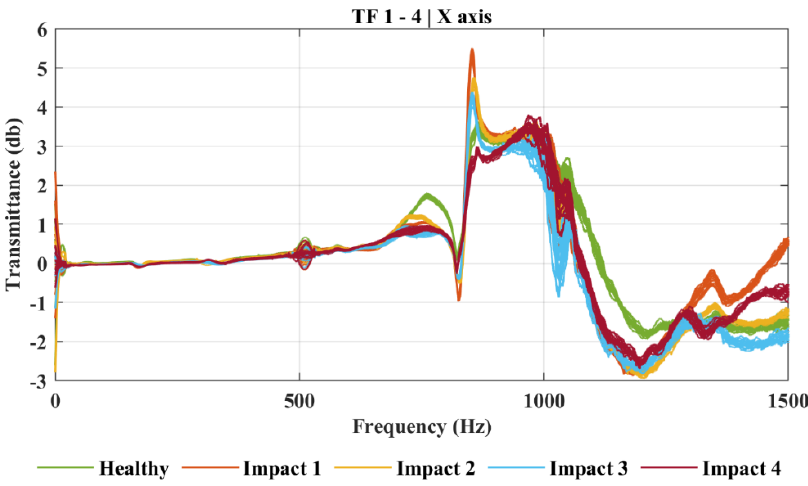
Figure 7. Transmittance functions (TF) on X-axis between accelerometer A1 and accelerometer A4.